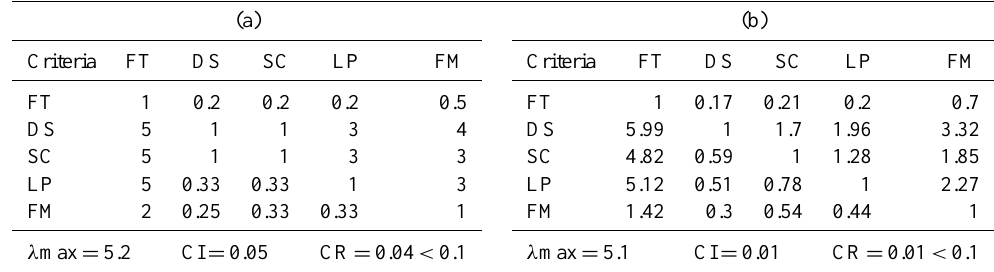
Table 2. Preference (pairwise comparison) matrix for one respondent (a) and for group judgement (b).